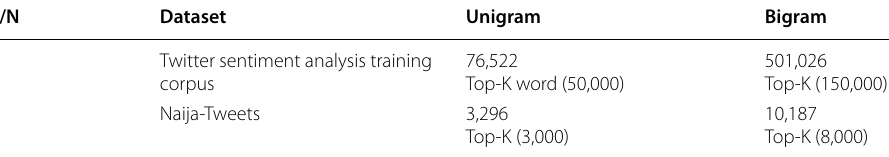
Table 10 Summary of feature extraction and representation